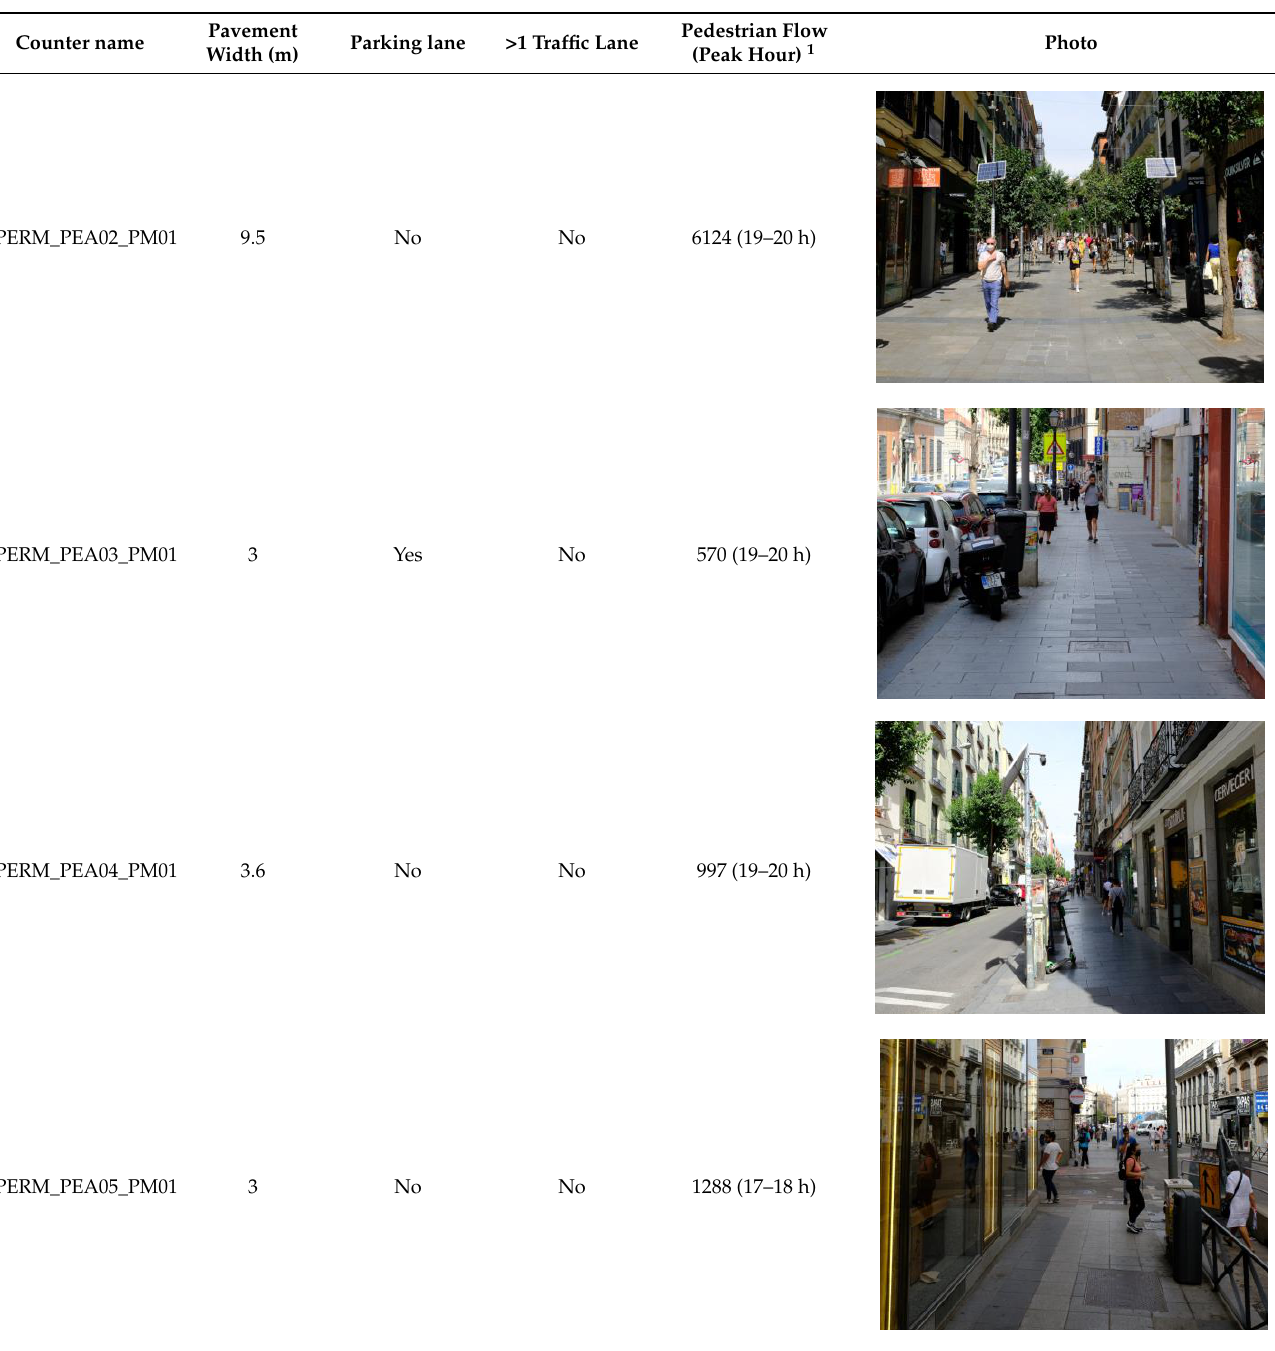
Table A1. Street characterisation of pedestrian counter